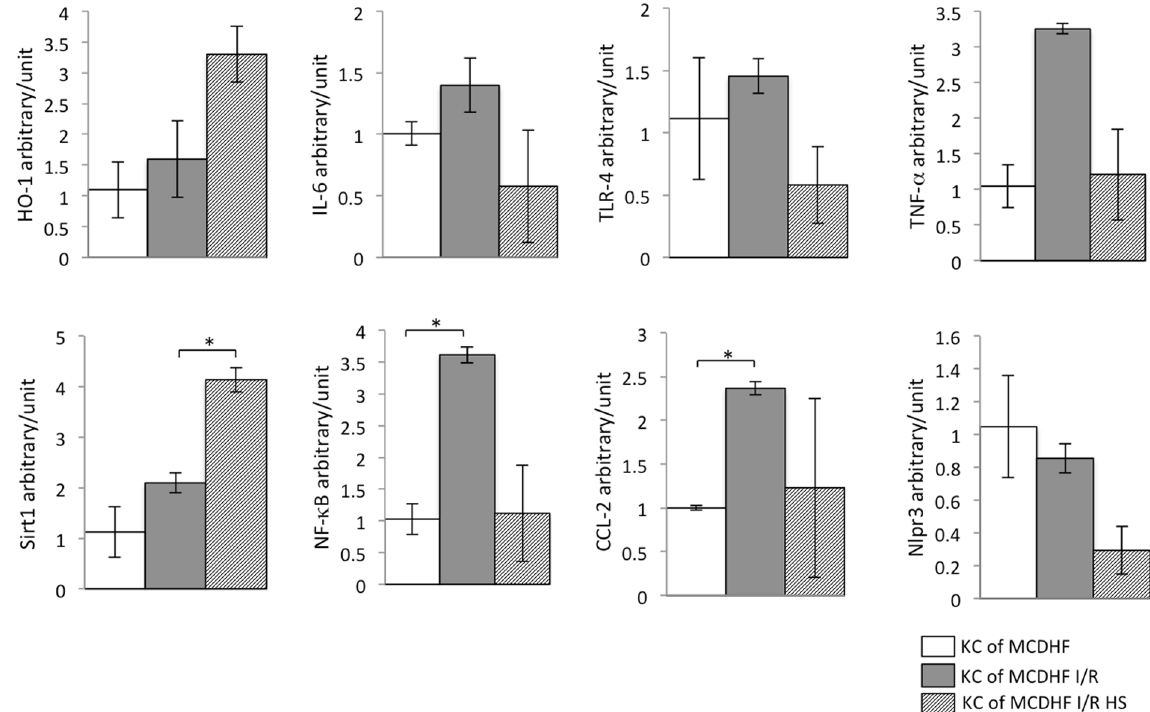
Figure 3. Hydrogen saline treatment induced Sirt1, HO-1 up-regulation, and the expression of inflammatory cytokine mRNA down-regulation in KCs isolated from the steatotic liver subjected to I/R. The mRNA expressions of inflammatory cytokines (TNF- α , IL-6, TLR-4, NF- κ B, CCL-2), an inflammatory mediator (Nlrp3), and the expression of Sirt1 and HO-1 in KCs from fatty livers after I/R were checked by RT-PCR analysis (n = 3). Data are expressed as the means ± SEM; * p < 0.05. Data are representative of three independent experiments and indicate the mean ratio of triplicate results from each